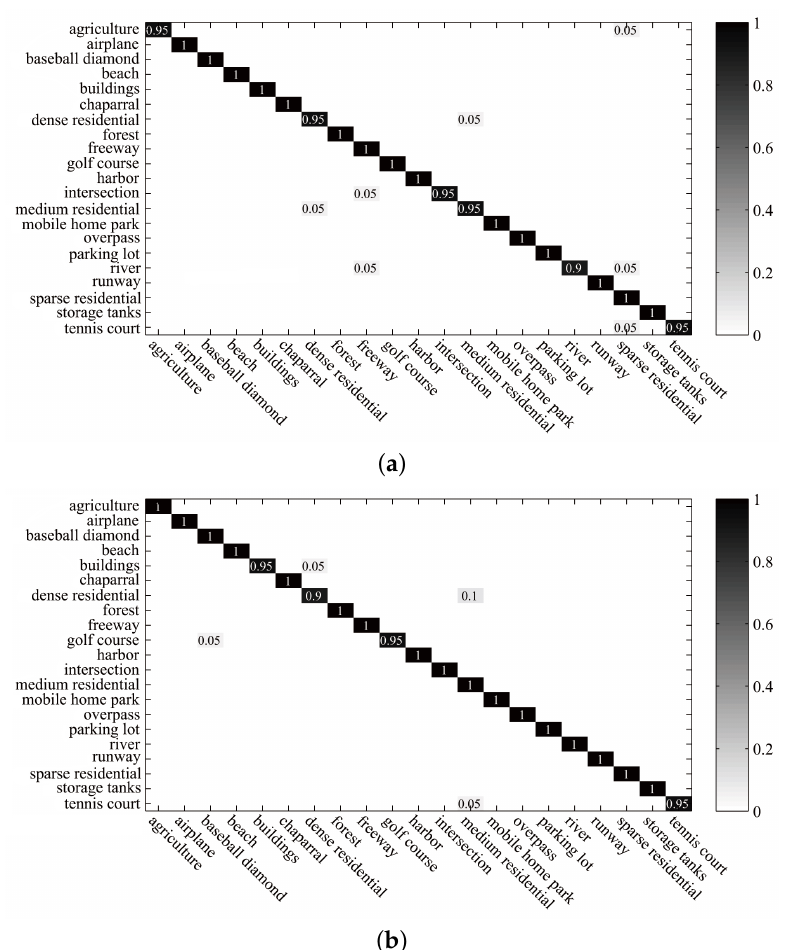
Figure 11. Confusion matrixes of the UC-Merced dataset under the training ratio of 80% using the following methods. ( a ) texture coded two-stream architecture with our proposed fusion model; ( b ) saliency coded two-stream architecture with our proposed fusion